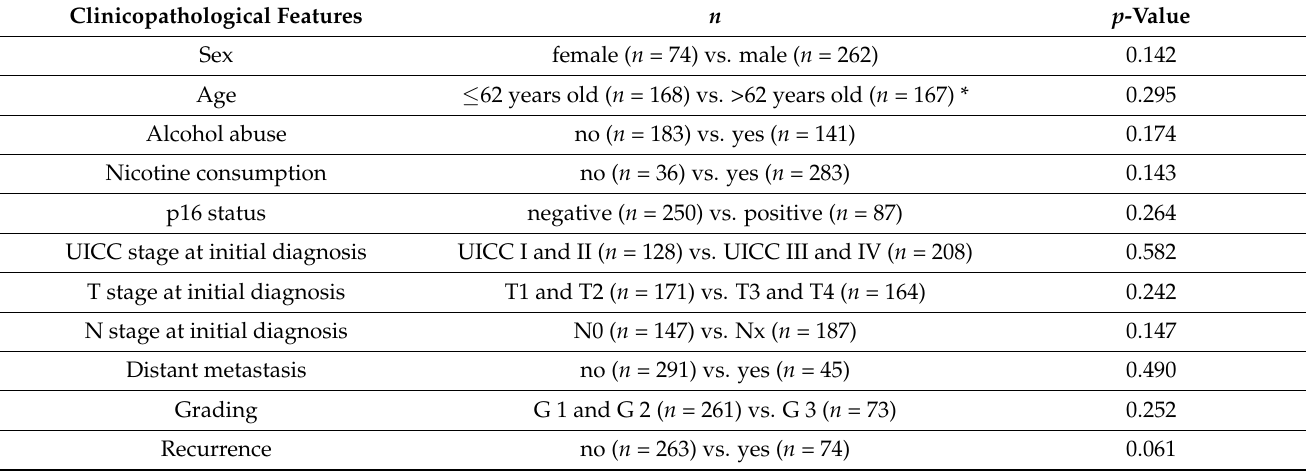
Table 2. TRIM21 expression in primary tumors regarding different clinicopathological features. p -values were calculated using the Mann–Whitney